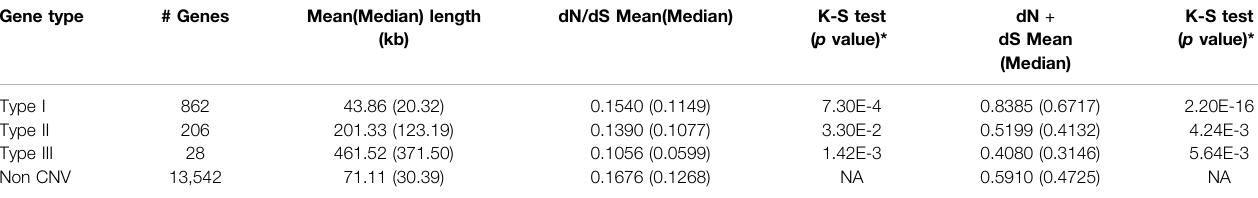
TABLE 3 | The mean and median values of length of genes, dN/dS, and dN + dS for the three types of CNV